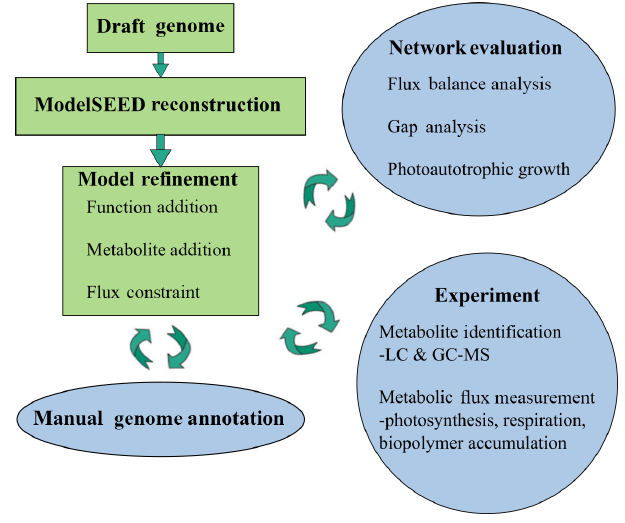
Figure 1. Metabolic reconstruction process